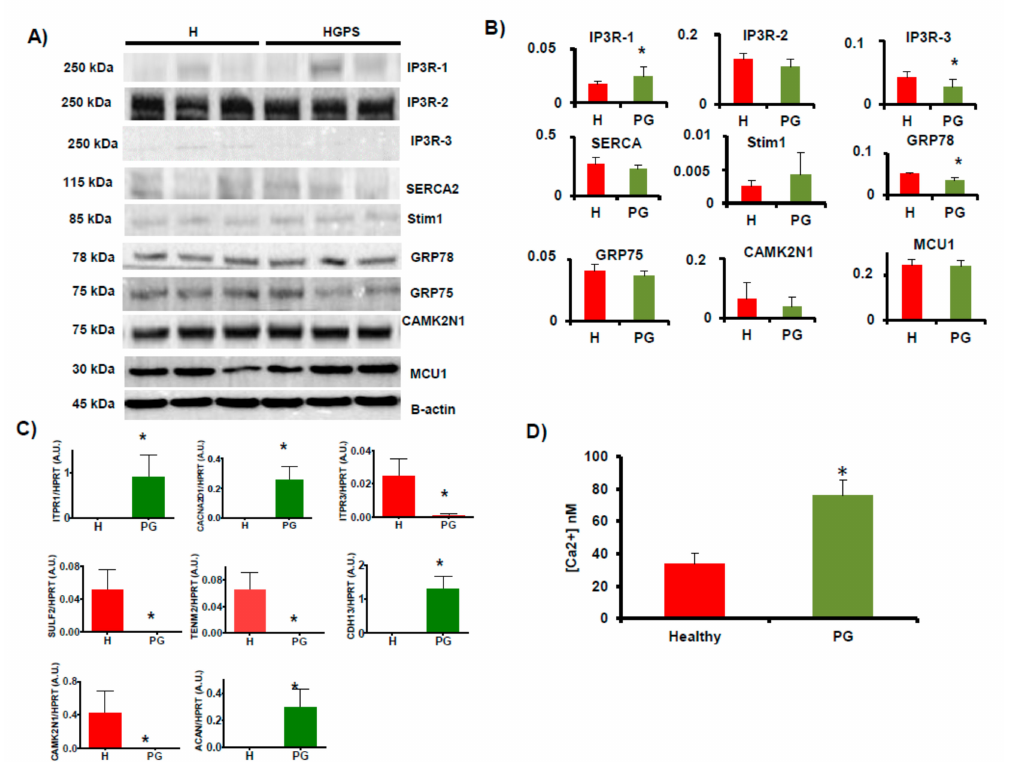
Figure 2. Study of receptors involved in Ca 2+ signaling. ( A ) Western blots of lysates from healthy (AG03257, AG03258, AG03512, and AG06299) and HGPS (AG03198, AG03199, AG03513, and AG06917) human skin fibroblasts. Antibodies used are indicated in Table A2. ( B ) Densitometry for normalized proteins relative to β -actin. ( C ) Histograms representing different gene expression levels normalized with HPRT used as housekeeping gene in healthy and HGPS human skin fibroblasts. ( D ) Total basal Ca 2+ measured in healthy (AG03257, AG03258, AG03512, and AG06299) and HGPS (AG03198, AG03199, AG03513, and AG06917) human skin fibroblasts using a luminescence spectrometer. Bars are means ± SEM from three independent experiments. * p < 0.05 was considered statistically significant. H = healthy, PG =